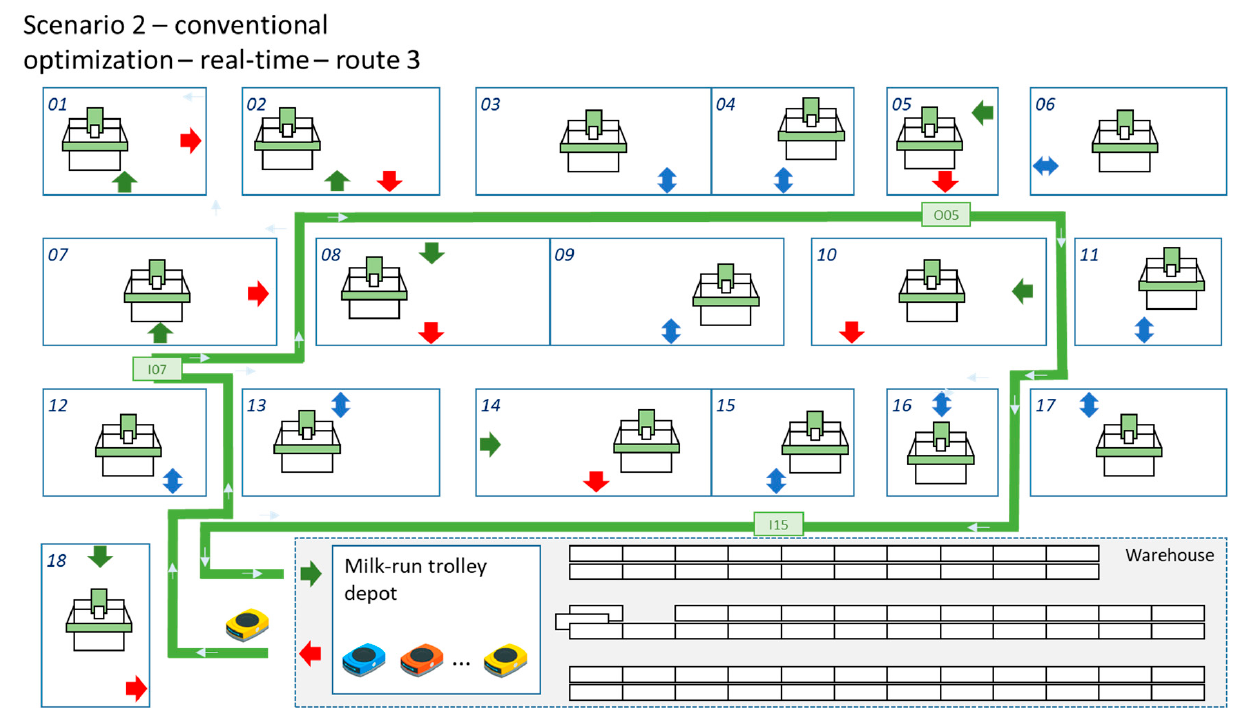
Figure 10. The third route of the conventional milk-run-based in-plant supply including real-time supply demand. Table 8. Numerical results of the conventional optimization of real-time supply demands performed by the milk-run trolley within the additional route 6.